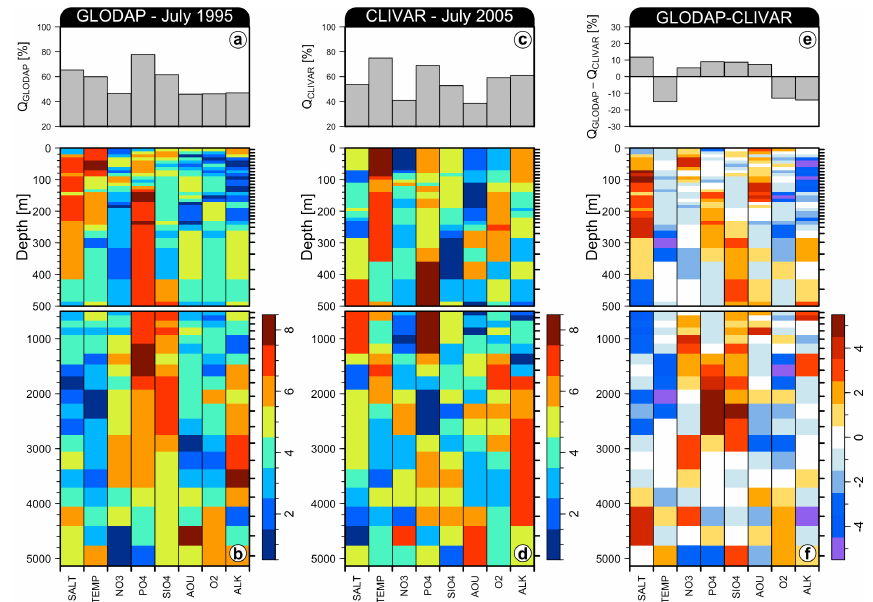
Fig. 4. Summary of the frequency of occurrence of the variables in the formulae of the best fitting models in each size class given the 1995 GLODAP (a, b) or the 2005 CLIVAR (c, d) stations and the difference between the two cases (e, f) . The color scale indicates the total number of times a variable is present summed over each best-fit formula across all size classes for each horizontal layer ( v i , the maximum is 8 for each layer). (a, c, e) Relative frequency of occurrence of each variable integrated over all depth layers and normalized to the maximum P D i = 0 v i possible occurrence, for each variable j , Q j = , where D is the number of vertical 8 D